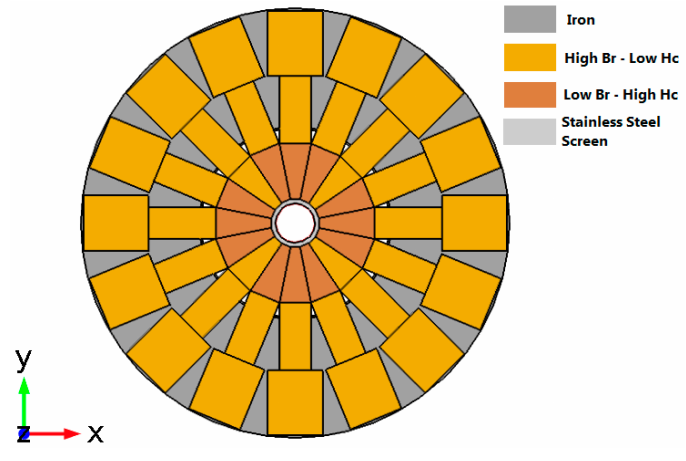
Figure 5. ELIMED PMQs